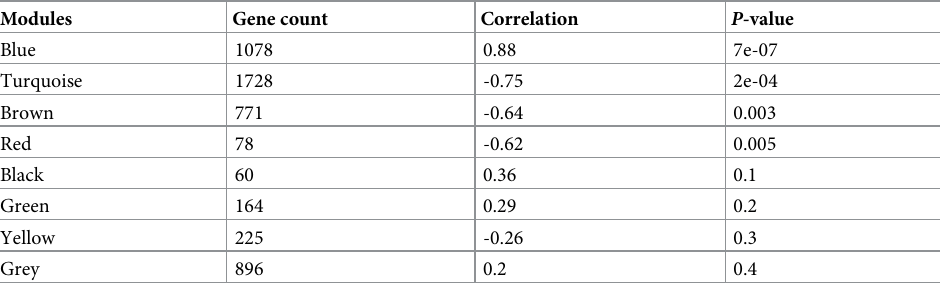
Table 1. Correlation between modules and smoking-related postmenopausal